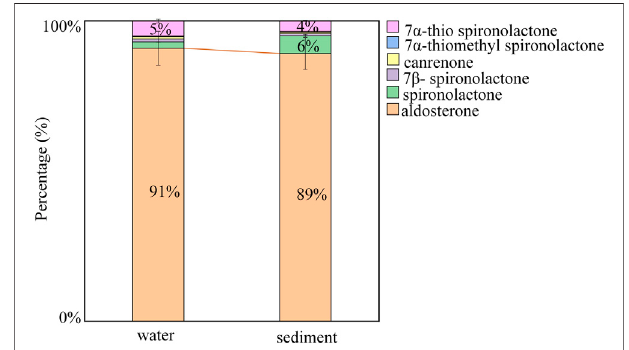
FIGURE 5 | Pro fi les of the six mineralocorticoids in water and sediment samples from Taihu Lake. Error bars represent SD values of two duplicate composite samples.